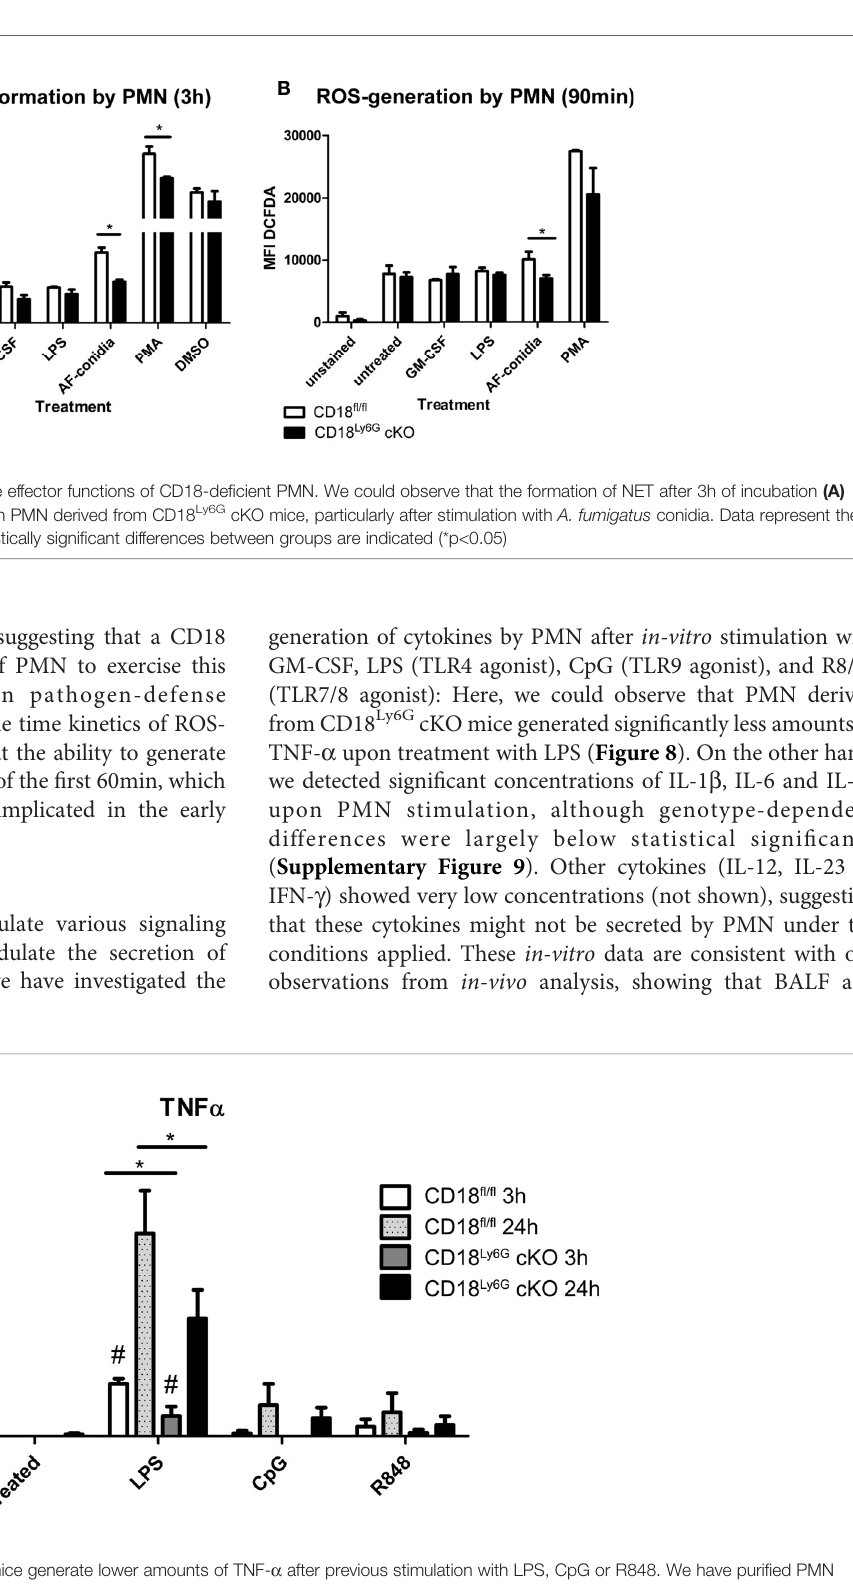
FIGURE 8 | PMN derived from CD18 Ly6G cKO mice generate lower amounts of TNF- a after previous stimulation with LPS, CpG or R848. We have puri fi ed PMN from CD18 fl / fl (n=3) mice and CD18 Ly6G cKO (n=3) mice and incubated them for 24h at the indicated conditions. After 3h and 24h supernatants have been taken and were analyzed using a CBA. Results show signi fi cantly lower levels of TNF- a in supernatants derived from CD18 Ly6G cKO mice. *p<0.05, # p<0.05 when comparing cytokine concentrations from supernatants at 3 vs